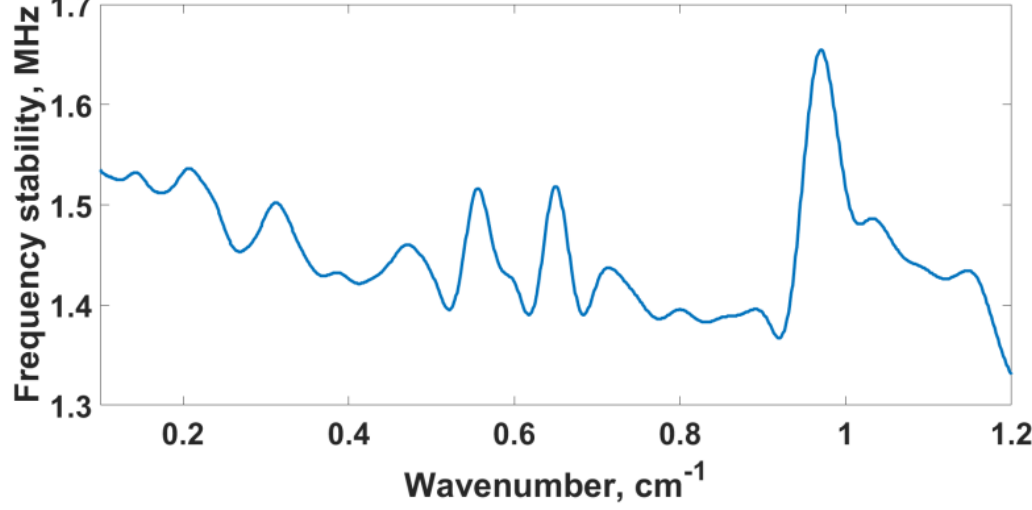
Figure 3. The deviation of the DL frequency within a single frequency sweep cycle. The average accuracy of frequency stabilization is about 1.5 MHz.